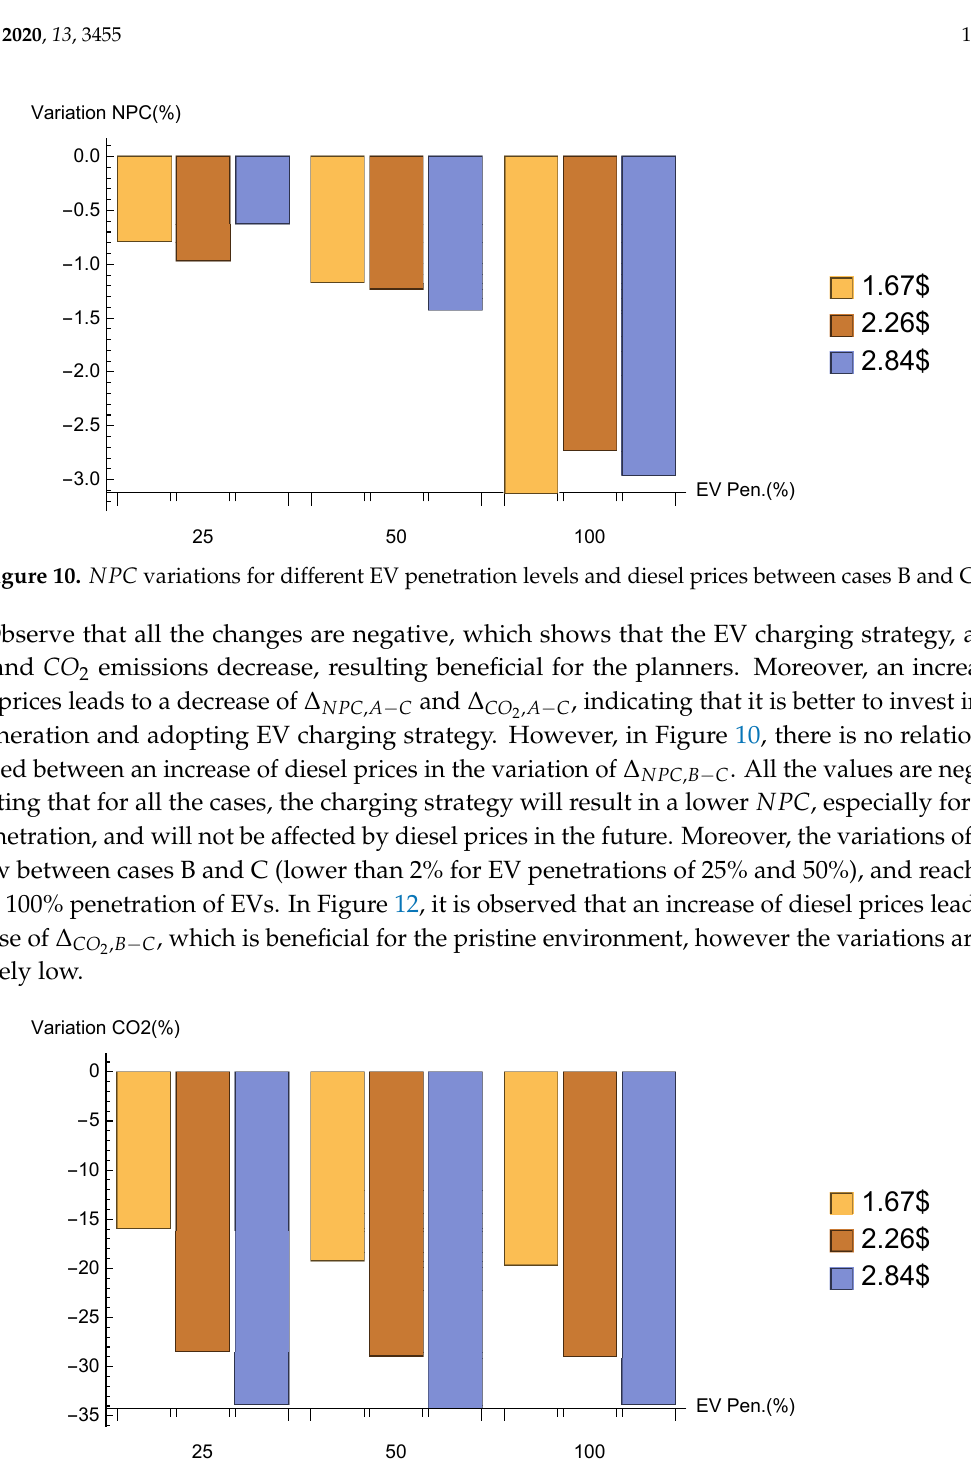
Figure 11. CO 2 variations for different EV penetration levels and diesel prices between cases A and